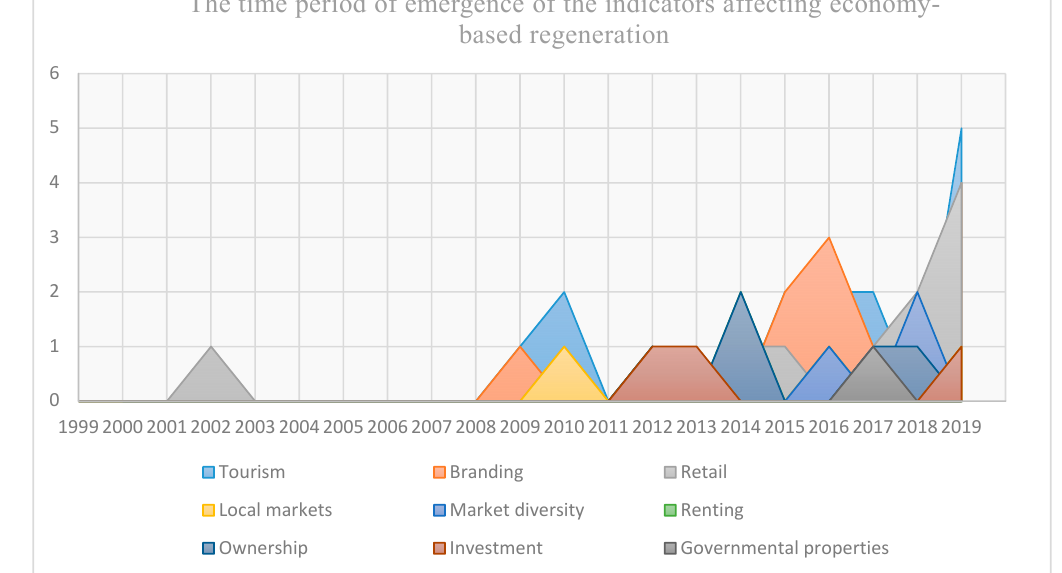
Figure 5. Time period of emergence of the indicators affecting economy-led regeneration.